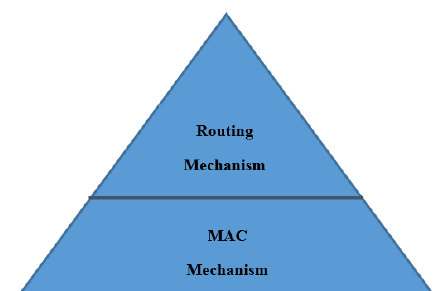
Figure 2. Decision-making hierarchy of opportunistic routing protocol.